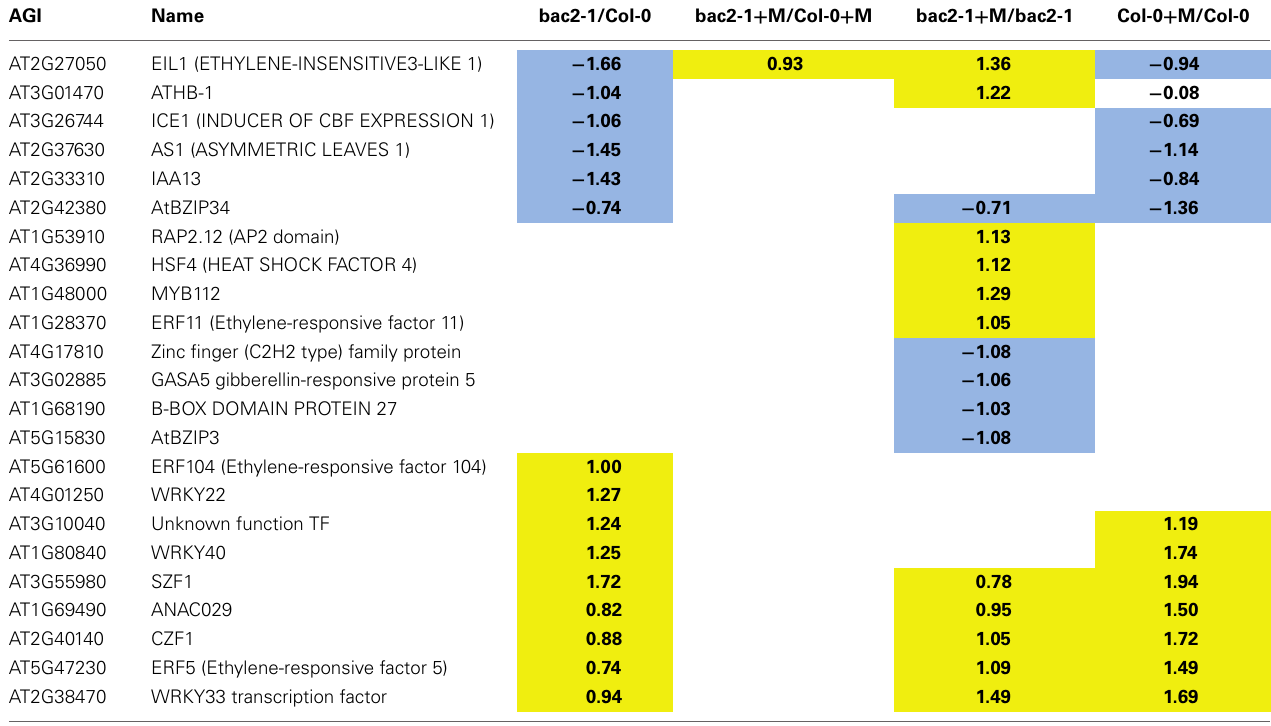
Table 1 | Transcription factor genes differentially expressed in bac2-1 . AGI